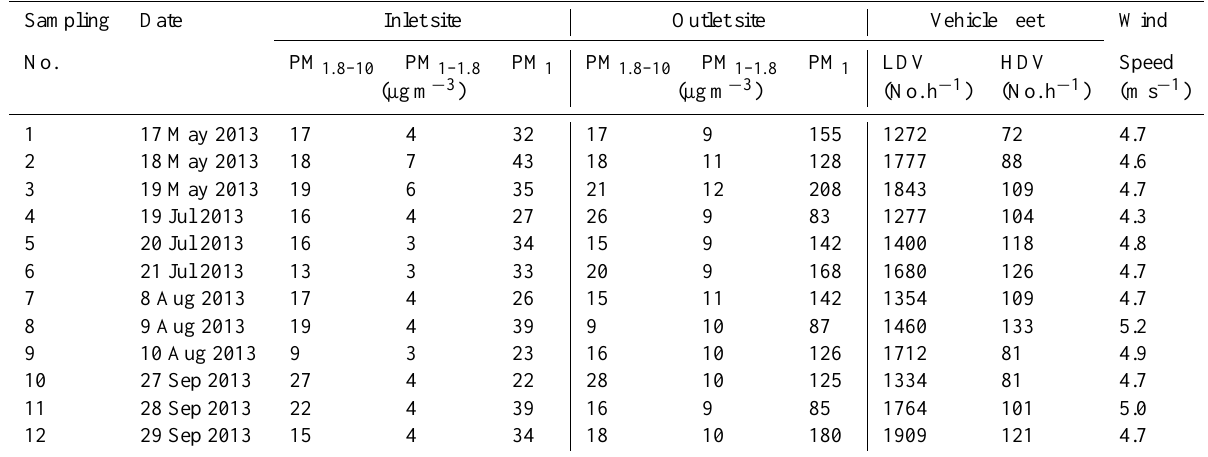
Table 1. Summary of sampling dates; mass concentrations (µgm − 3 ) of PM 1 . 8–10 , PM 1–1 . 8 , and PM 1 ; traffic flow; and wind speed in Hsuehshan Tunnel during the sampling periods in